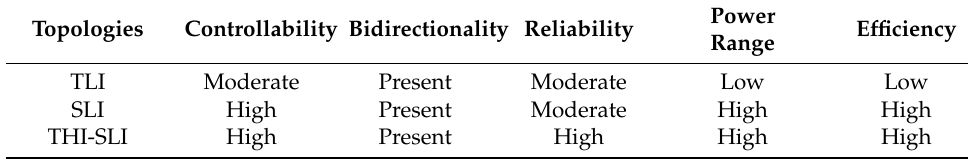
Table 12. Functionalities comparison of inverters.